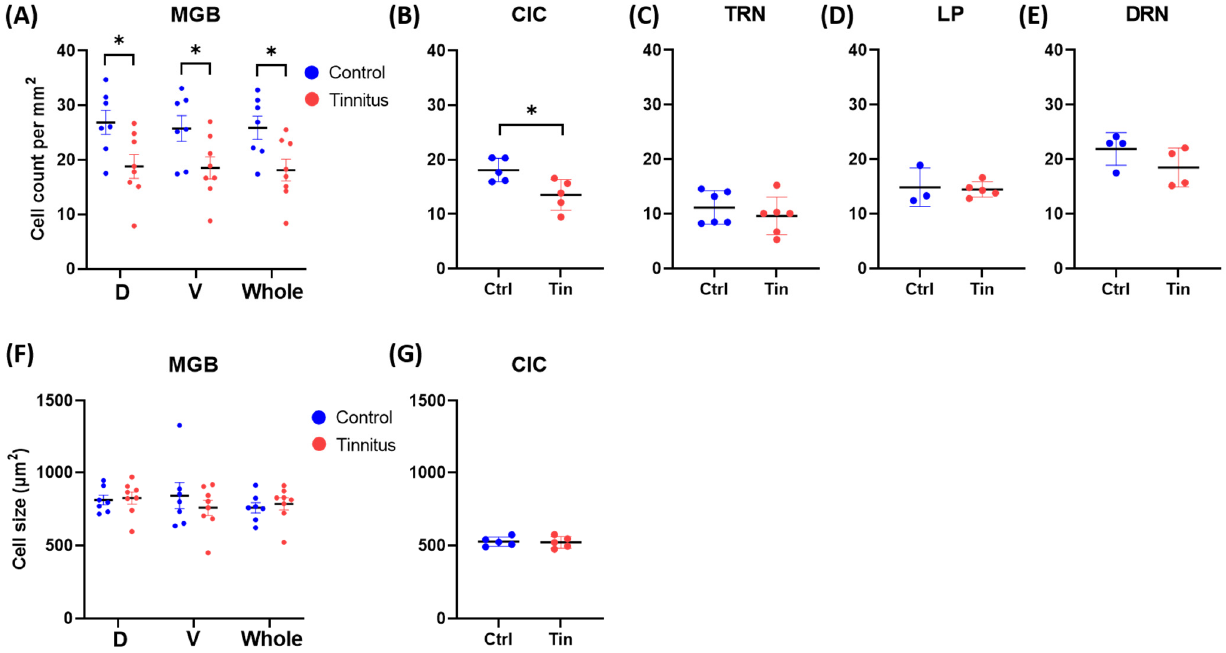
Figure 2. Cumulative data showing the mean cell density ( A – E ) and cell size ( F , G ) measured in Nissl-stained sections containing the anatomical areas. ( A , F ) graphs show the cell density and size, respectively, in (D) dorsal, (V) ventral, and MGB (as a whole). p value < 0.05 was defined as significant level and is indicated by an (*). Note the significant reduction in cell density in the MGB and its subdivisions ( A ), as well as in the CIC ( B ). CIC, central part of inferior colliculus; Ctrl, control group; DRN, dorsal raphe nucleus; LP, lateral nucleus of pulvinar; MGB, medial geniculate body; Tin, tinnitus group; and TRN, thalamic reticular nucleus.